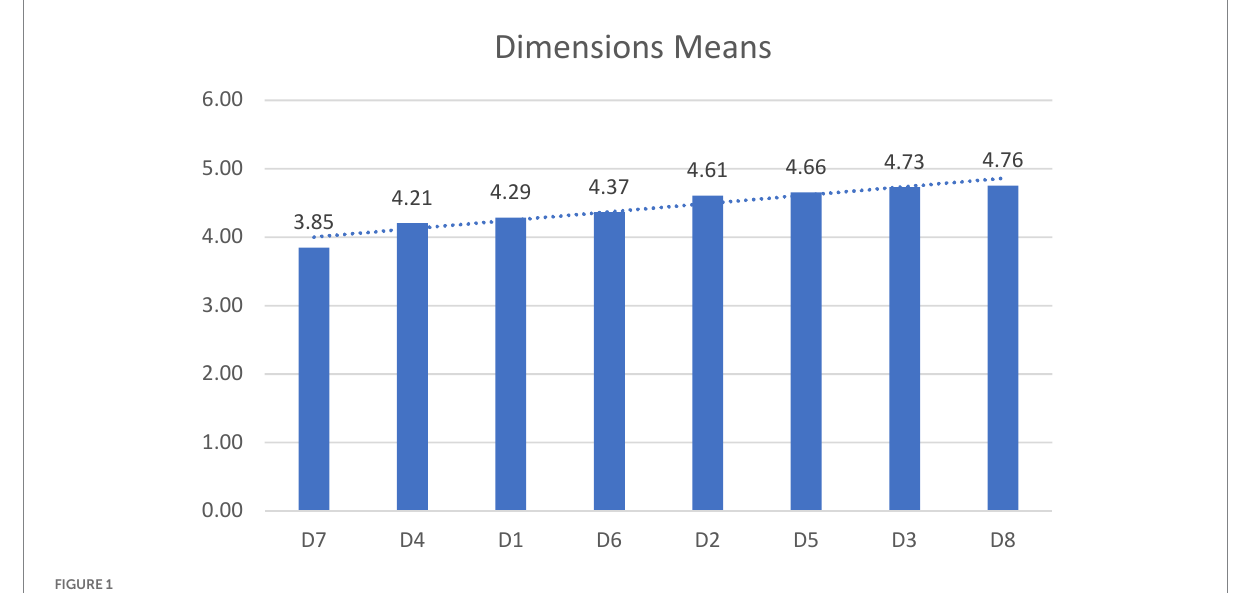
FIGURE 1 Dimensions means of the initial 24 items IQIB-ECEC online